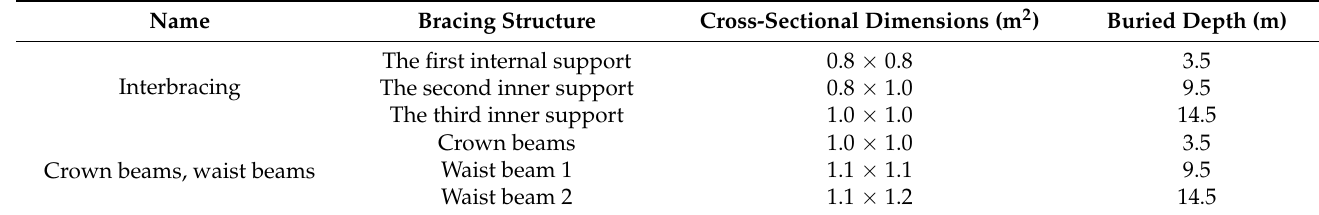
Table 1. Supporting structure design parameters.